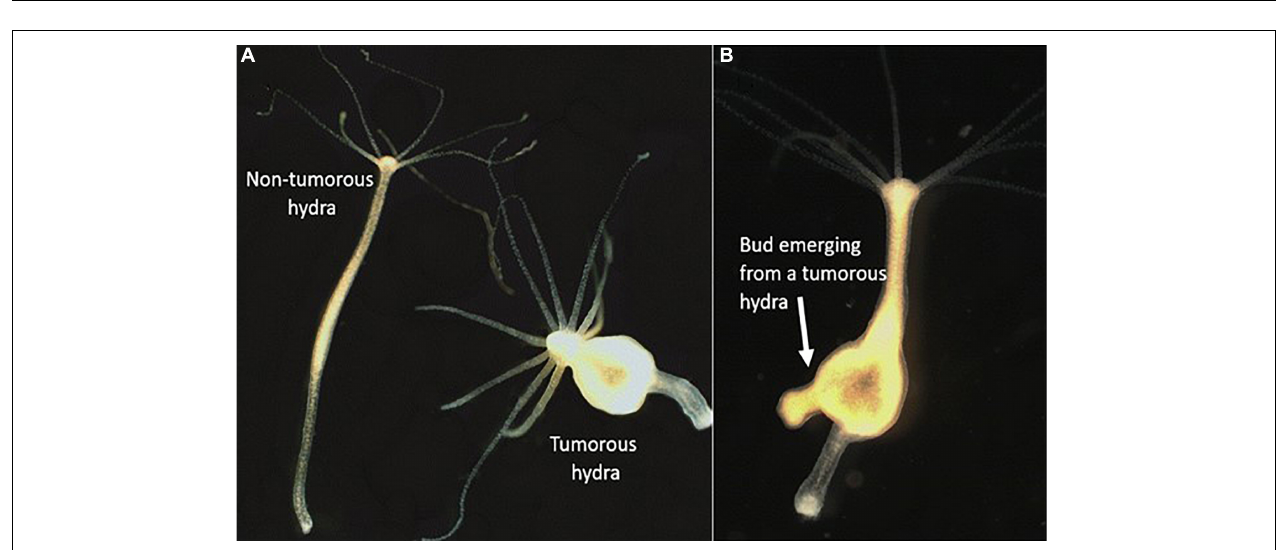
FIGURE 5 | Transmissible cancers in Tasmanian devils. Tasmanian devils with DFTD and DFT2 and the respective tumor karyotypes. Red arrows indicate chromosomes carrying cytogenetic abnormalities. The four marker chromosomes found in DFTD are labeled M1 to M4. Karyotypes from Pye et al. (2016).